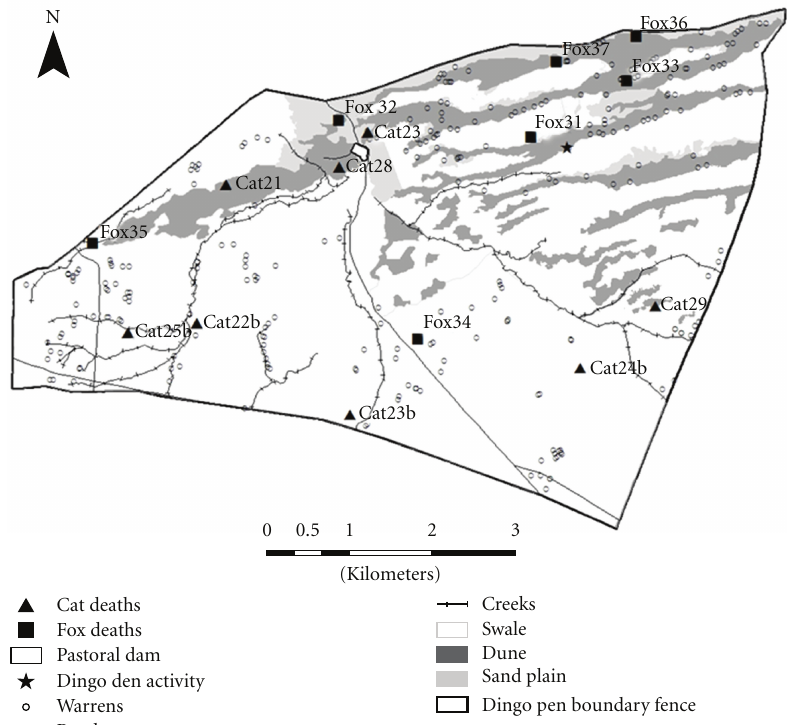
Figure 2: Location of animal deaths attributed to dingoes within the Dingo Pen. Habitat types, rabbit warrens, and the dingo den site are also